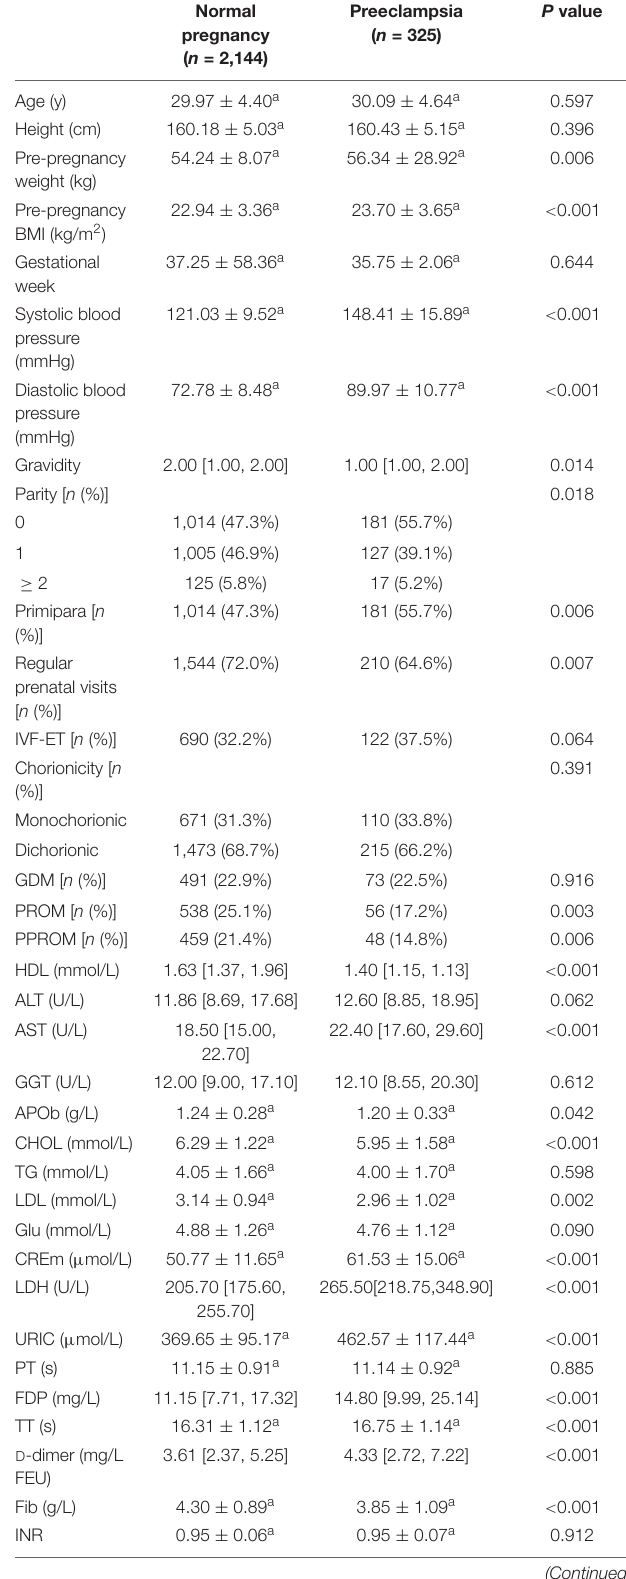
TABLE 2 | General baseline